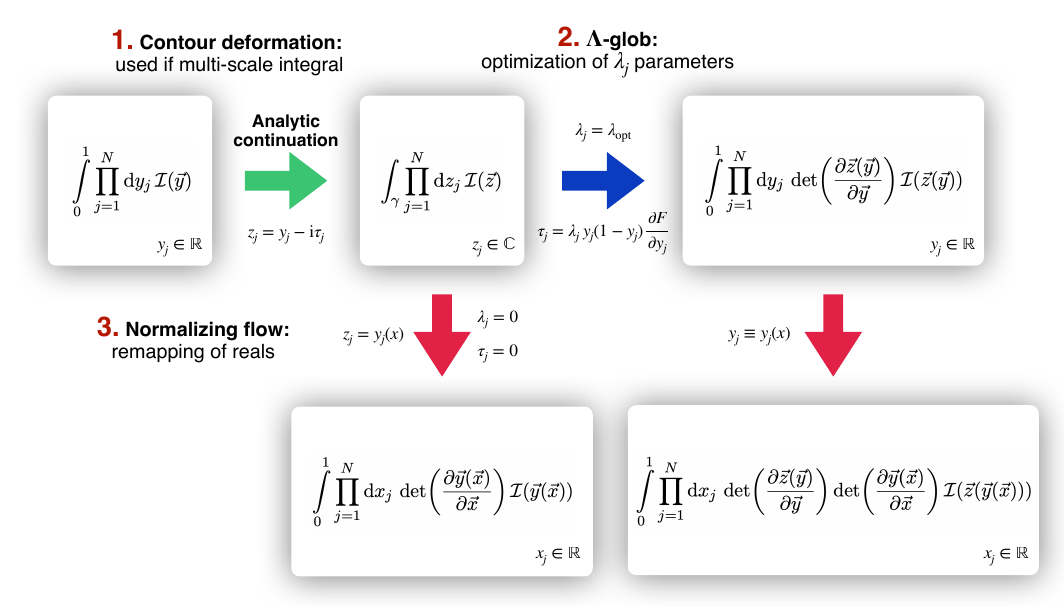
Figure 5: Schematic illustration of our